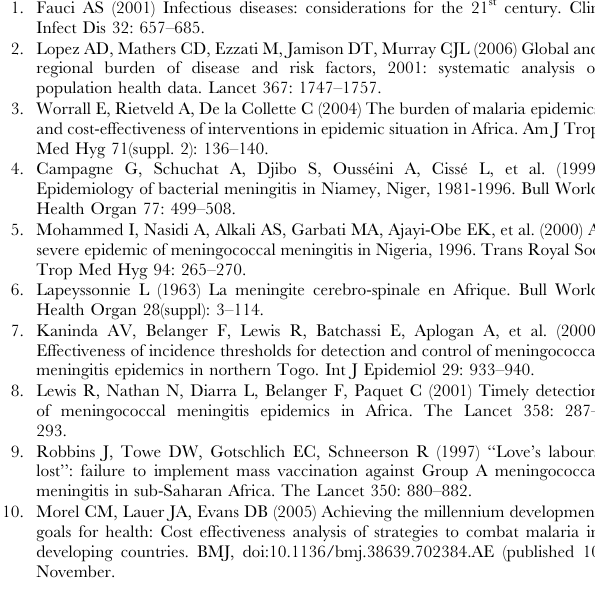
Table S2 Health outcomes and duration of meningococcal meningitis outbreak in selected districts before (1996-2002) and after (2003–2007) IDSR implementation in Burkina Faso.